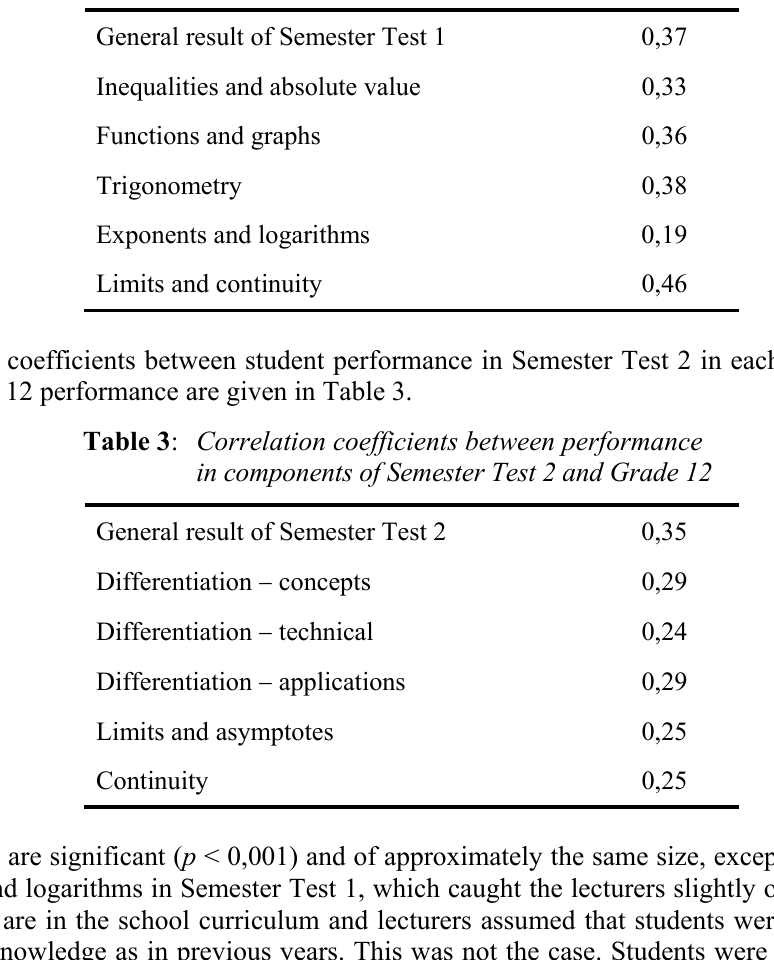
Table 2 : Correlation coefficients between performance